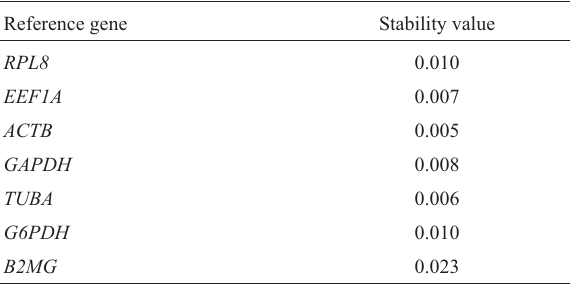
Table 4 - The stability of reference genes measured by Normfinder.